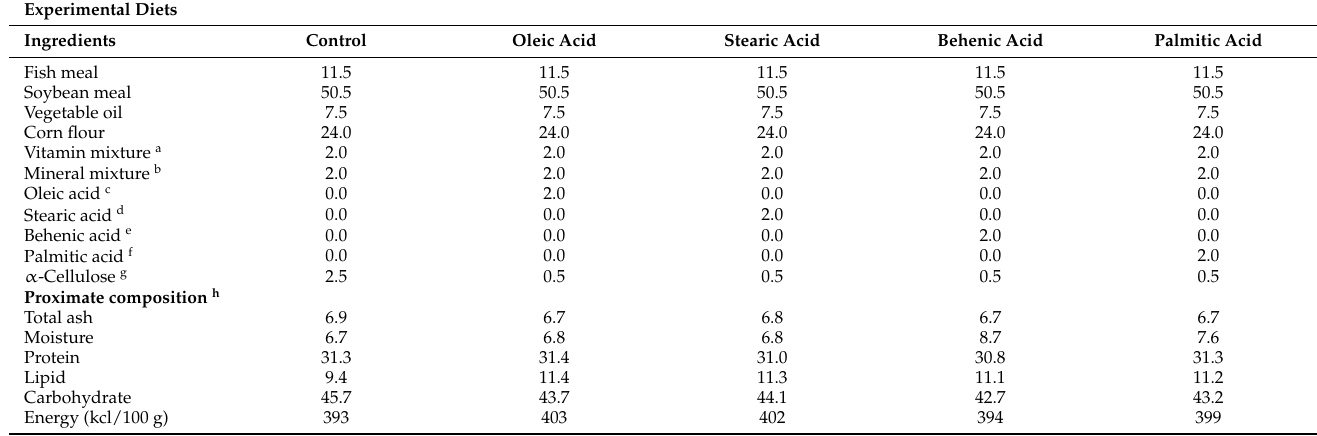
Table 1. Ingredient formulation (%) of the experimental diets with different types of fatty acid